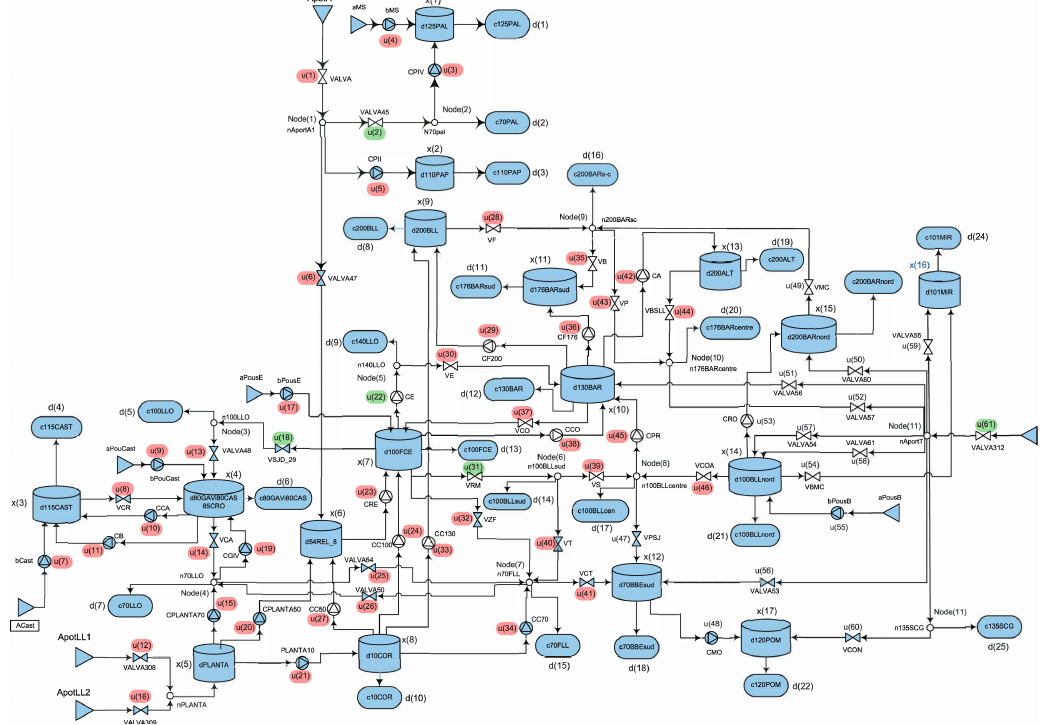
Figure 7. Barcelona drinking water network (17